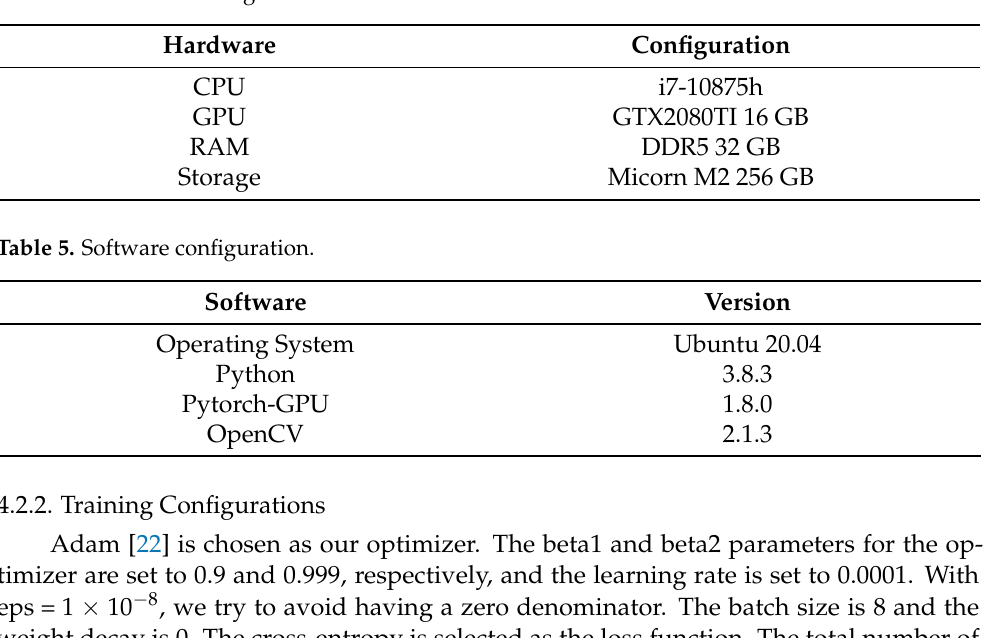
Table 4. Hardware Configuration.